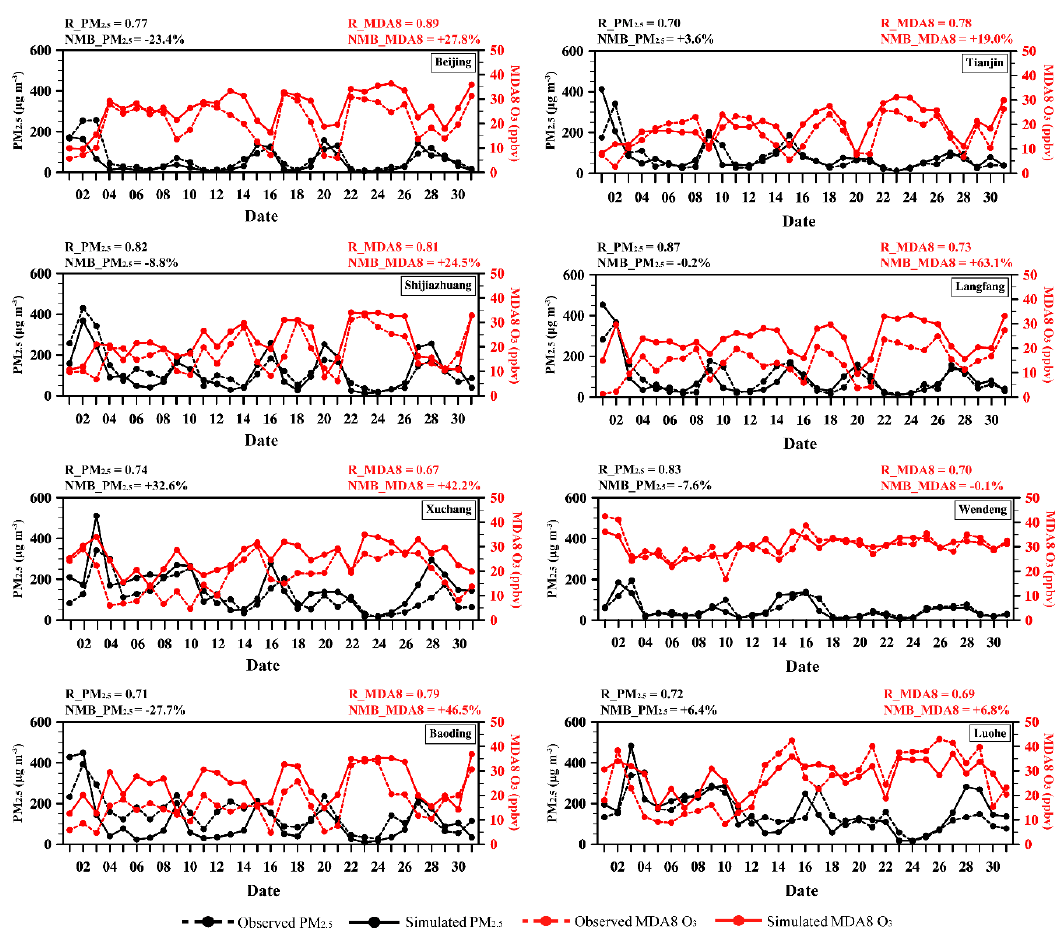
Figure 3. Observed and simulated daily PM 2.5 and MDA8 O 3 concentrations for northern cities in January. Observed (simulated) concentrations are shown in dashed (solid) lines. The PM 2.5 (MDA8 O 3 ) concentrations are shown in black (red) lines. The correlation coefficient ( r ) and normalized mean bias (NMB) between the observations and simulations are shown above each panel.